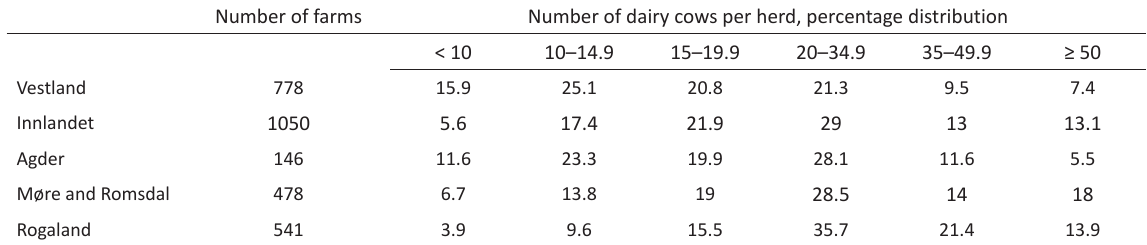
Table 2. Number and distribution of herds over different sizes in five selected counties in 2020. Data collected from the national dairy herd recording comprising 98 percent of all herds (Mikalsen, Österås and Roalkvam,